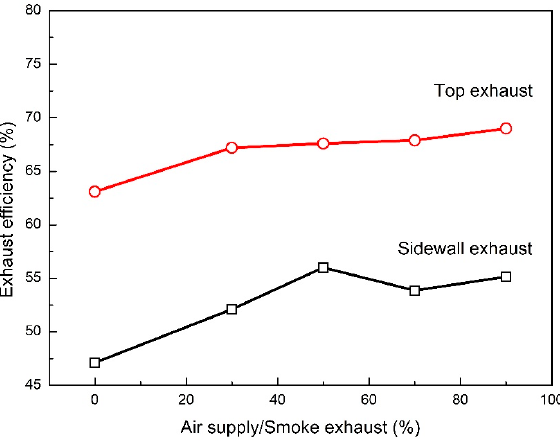
Figure 6. Smoke exhaust efficiency under different longitudinal air